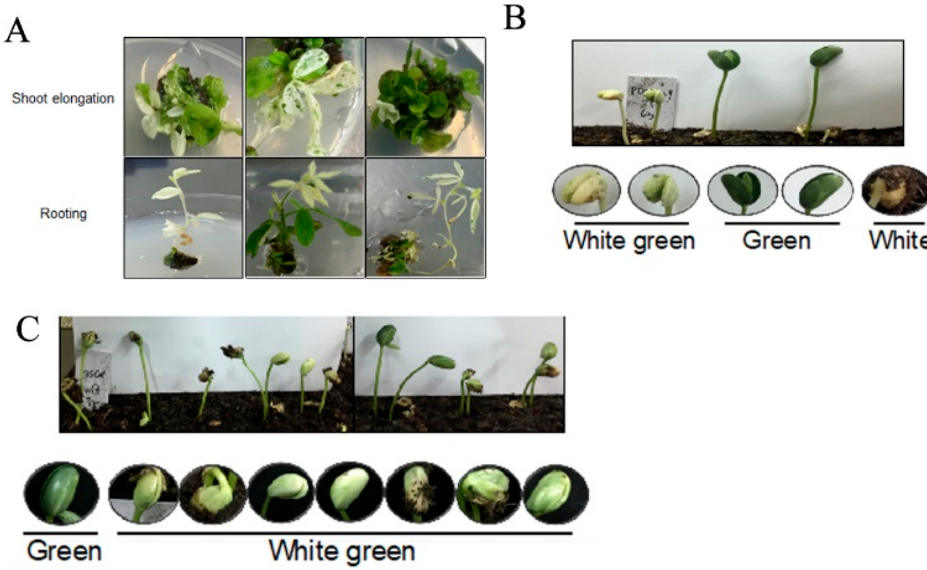
Figure 4. Segregation of the GmPDS mutation. ( A ) Phenotype of CRISPR/Cas9-mediated GmPDS knockout mutant during shoot elongation and rooting. ( B ) Segregation of the T 1 seeds harvested from T 0 GmPDS heterogenous mutant. ( C ) Segregation of the T 2 seeds harvested from T 1 GmPDS heterogenous mutant.